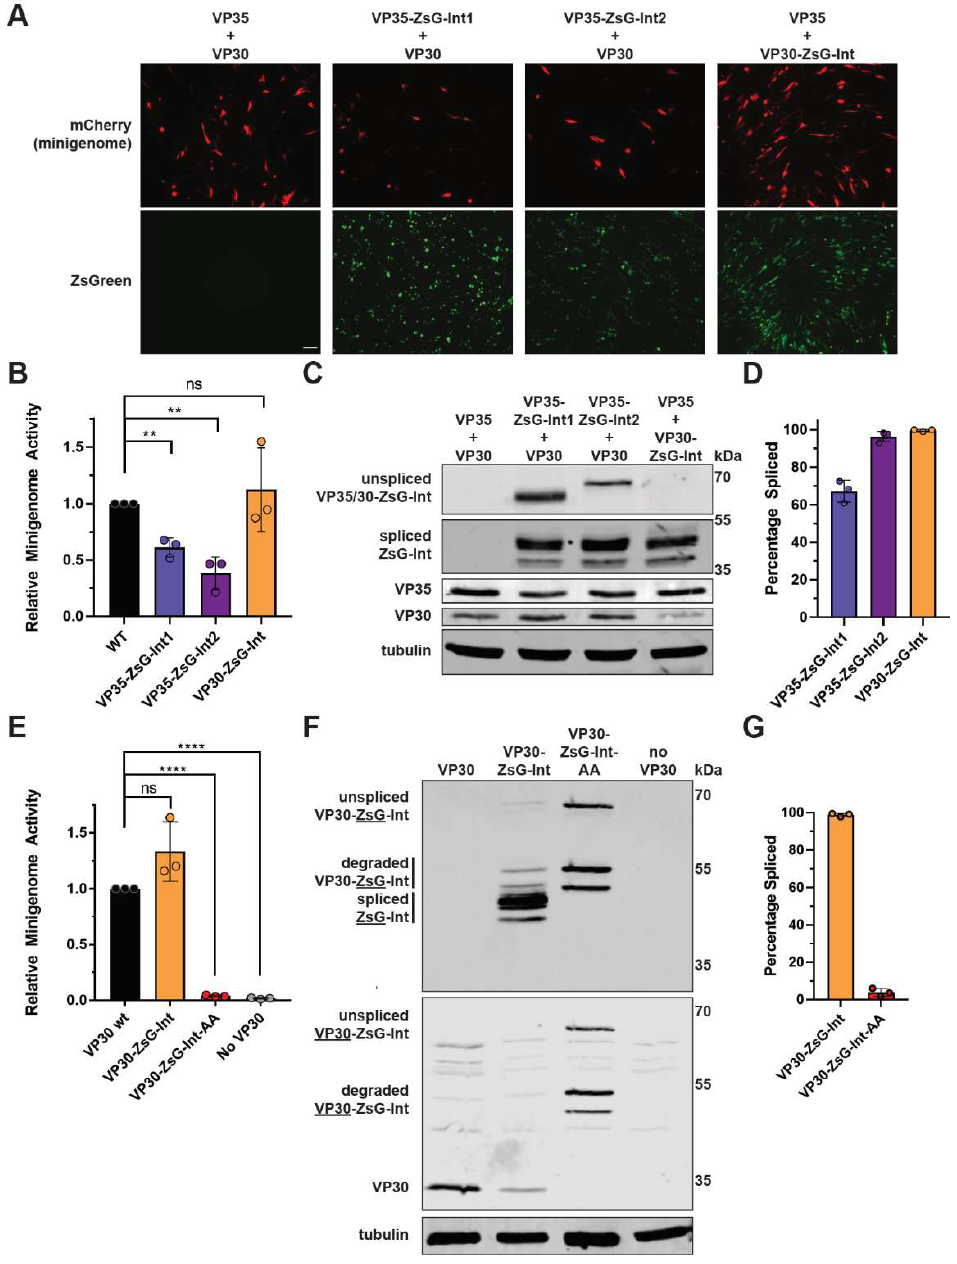
Figure 3. Functional assessment of VP35 and VP30 constructs containing ZsG-Int. ( A ) Minigenome activity (mCherry, red) of BHK21 cells expressing wild-type EBOV system components versus those substituted with the indicated ZsG-Int constructs. ZsG-Int expression (ZsGreen, green). Scale bar = 100 μm. Images were taken with 10× objective. ( B ) Minigenome activity (relative NanoLuc activity) of Huh7 cells expressing wild-type EBOV system components versus those substituted with the indicated ZsG-Int constructs. ** = p < 0.01, ns = not significant. ( C ) Western blot analysis of cell lysates from ( B ). ( D ) Protein splicing efficiencies from C based on 3 replicates were quantified and calculated as in Figure 2D. ( E ) Minigenome activity (relative NanoLuc activity) of Huh7 cells expressing wild-type EBOV VP30, VP30-ZsG-Int, VP30-ZsG-Int-AA, or no VP30. **** = p < 0.0001, ns = not significant. ( F ) Western blot analysis of cell lysates from ( E ). Numbers on the right indicate molecular mass of protein marker bands. Antibodies detecting ZsGreen and VP30 were used for the top and middle blots, respectively. ( G ) Protein splicing efficiency from ( G ) based on 3 replicates was quantified and calculated as in Figure 2D. Experiments have been performed 3 times with similar outcomes. Representative results are shown in ( A , C , F ).